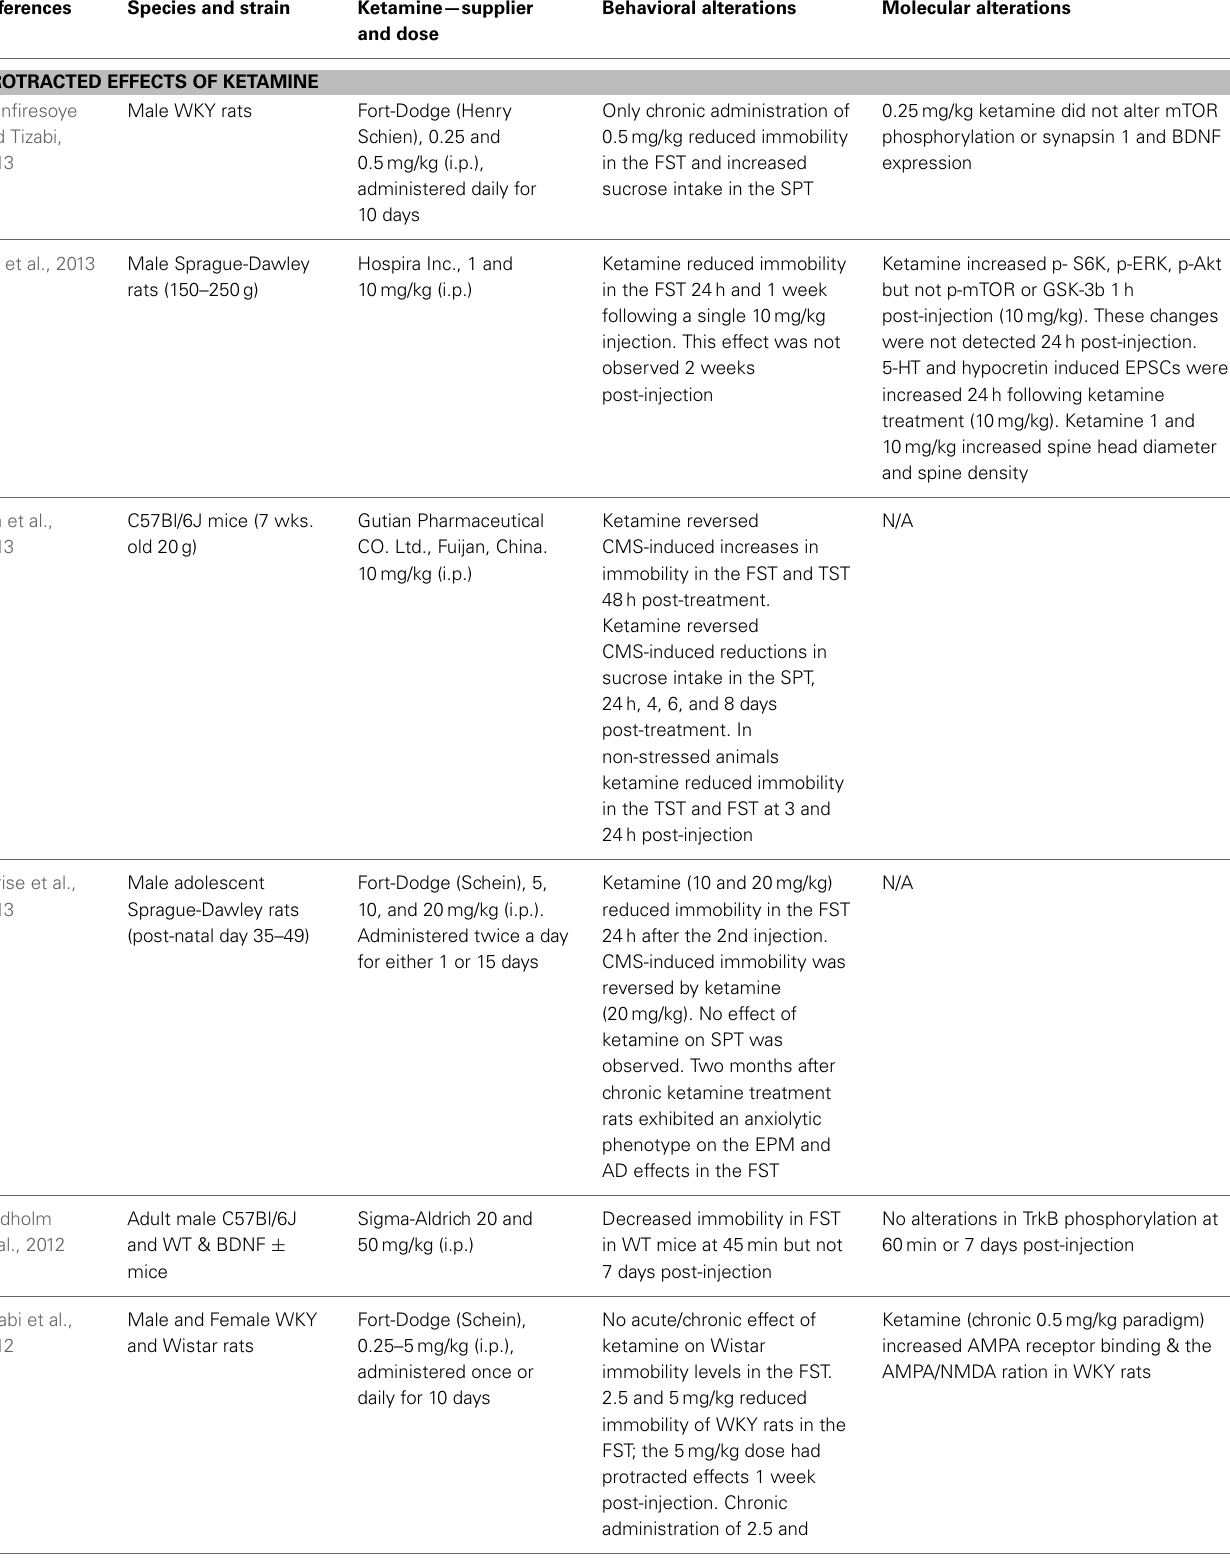
Table 2 | Protracted effects of